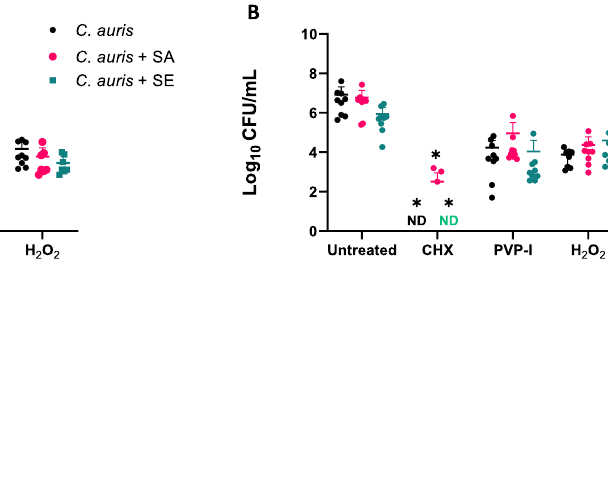
Figure 3. Multi-species biofilms do not provide additional protection against antiseptics. Single and dual-species biofilms of C. auris and either S. aureus (SA) or S. epidermidis (SE) were grown for 24 h before being challenged with 2% ( v/v ) CHX, 10% ( w/v ) PVP-I, or 3% ( v/v ) H 2 O 2 for 5min with subsequent neutralisation with 5% ( v/v ) sodium thiosulphate. Immediately following neutralisation,